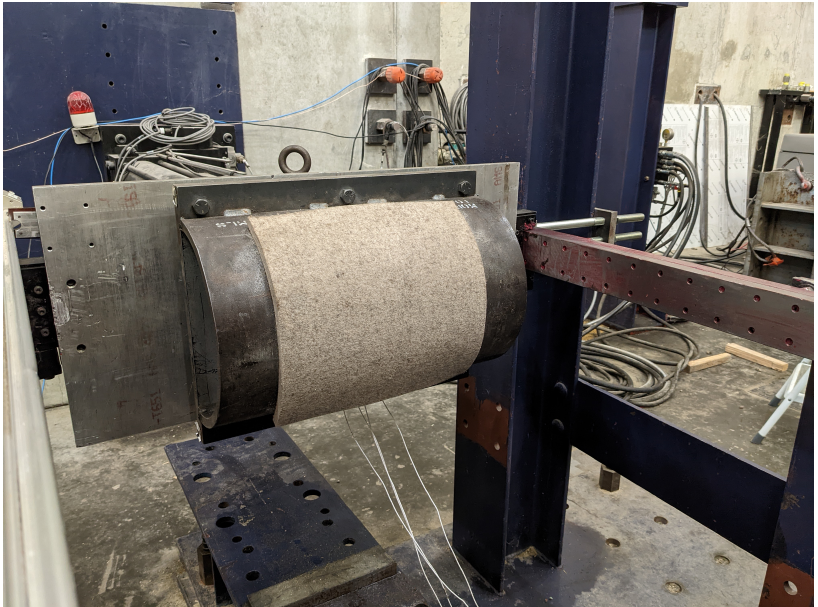
Figure 9. Impactor with load cells attached to pusher